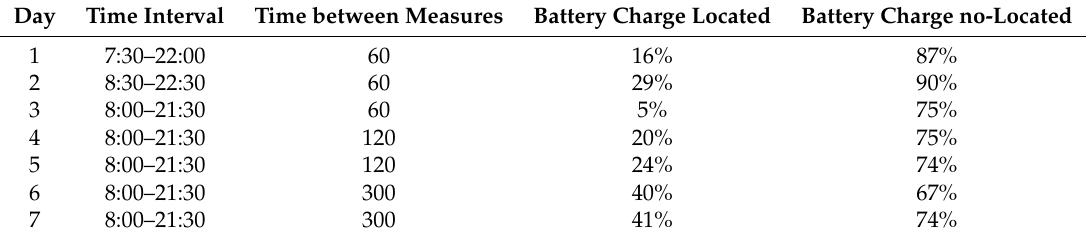
Table 8. Battery usage for a smart-watch running the indoor location Android application compared with a smart-watch which does not run the application. The time between measures is shown in seconds. The charge remaining is shown as a percentage of the full